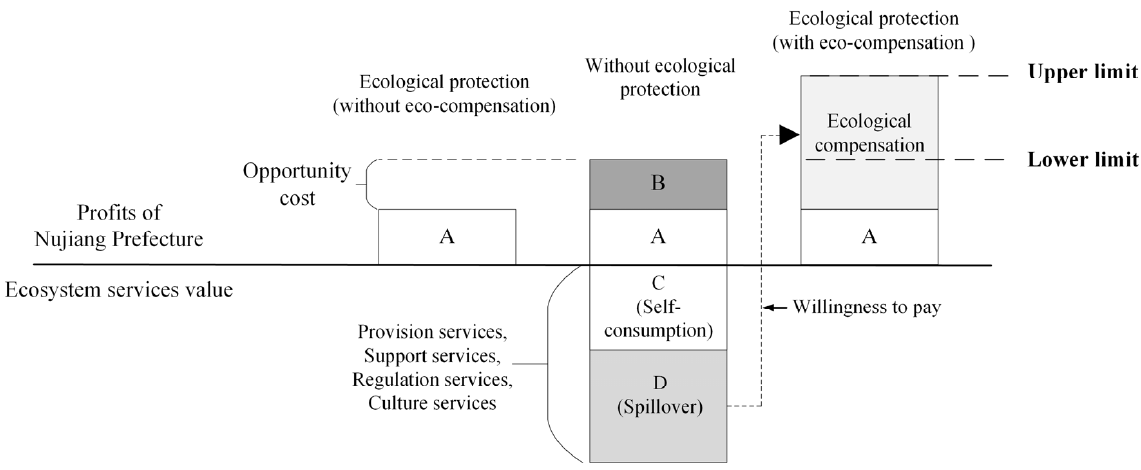
Figure 1. Theoretical analysis framework.